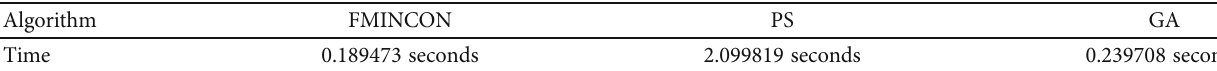
Table 7: Time simulation.